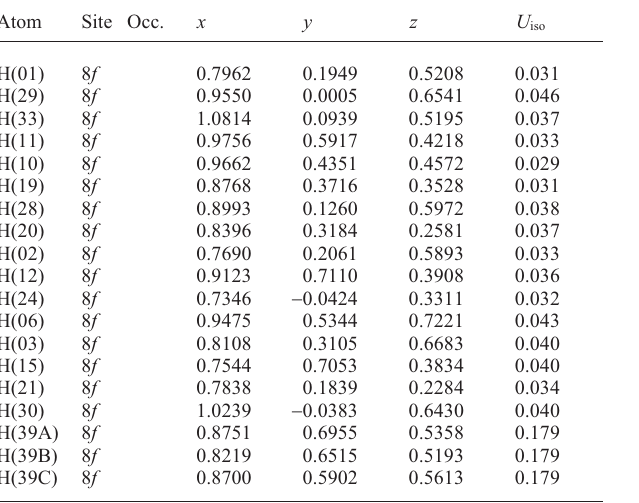
Table 3. Atomic coordinates and displacement parameters (in Å 2 )